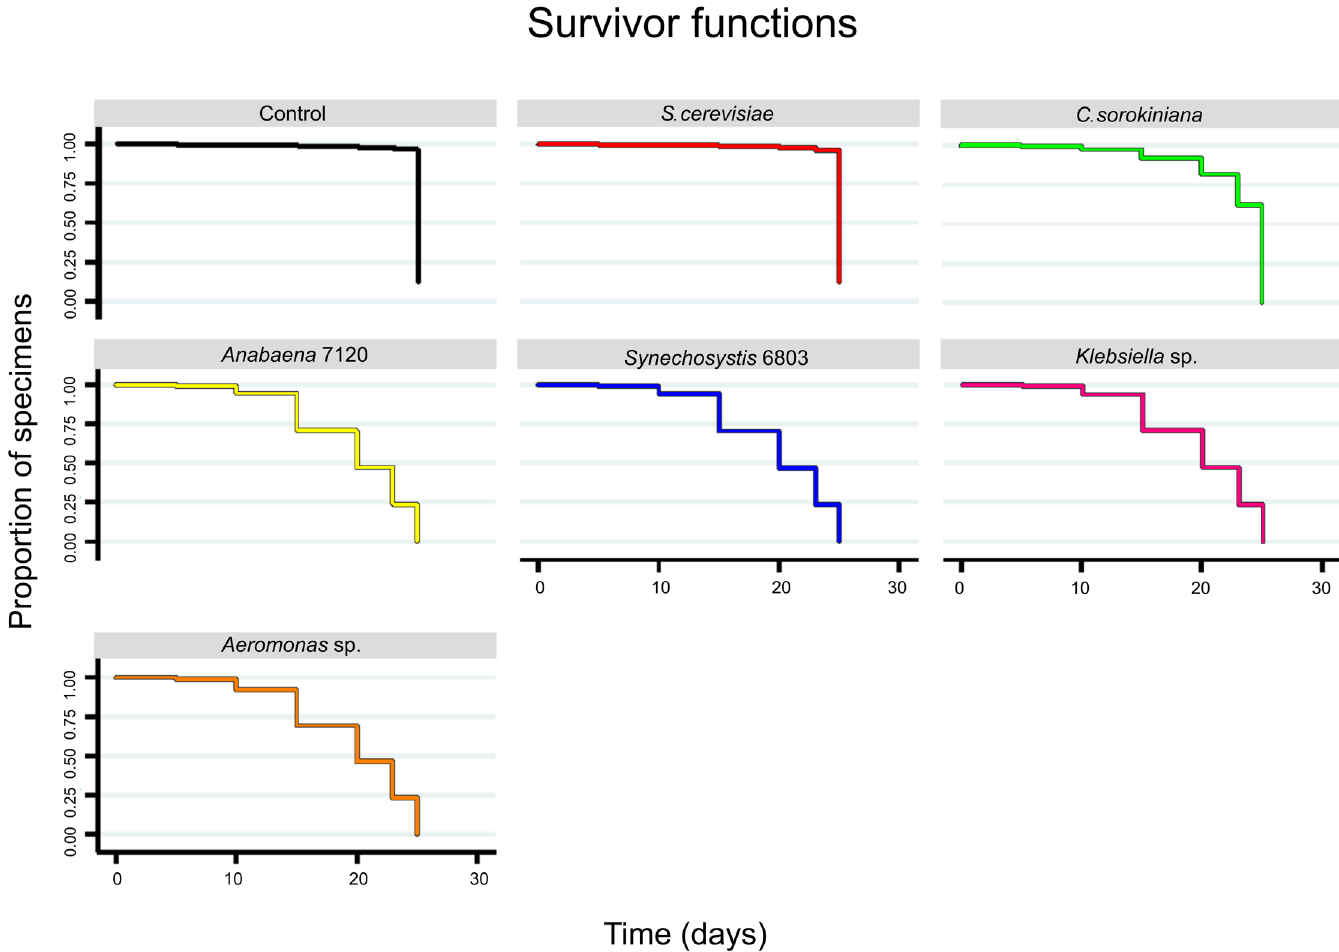
Fig 3. Survival curves. Kaplan-Meier survival curves per treatment (Treatment = microorganism, N individuals at the experiment started = 160, α = 0.05) were estimated from total individuals of each treatment ( S . cerevisiae , C . sorokiniana , Anabaena 7120, Synechocystis 6803, Klebsiella sp. and Aeromonas sp.).